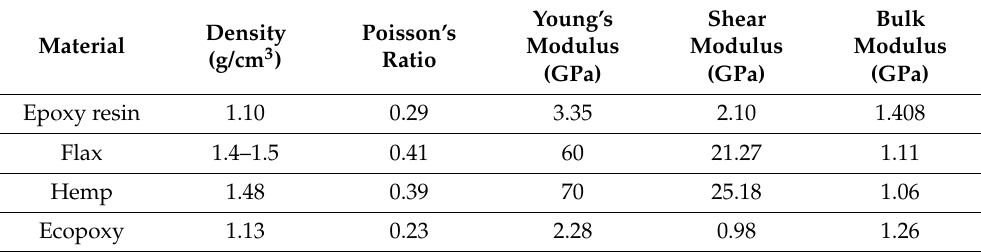
Table 2. Mechanical properties of the